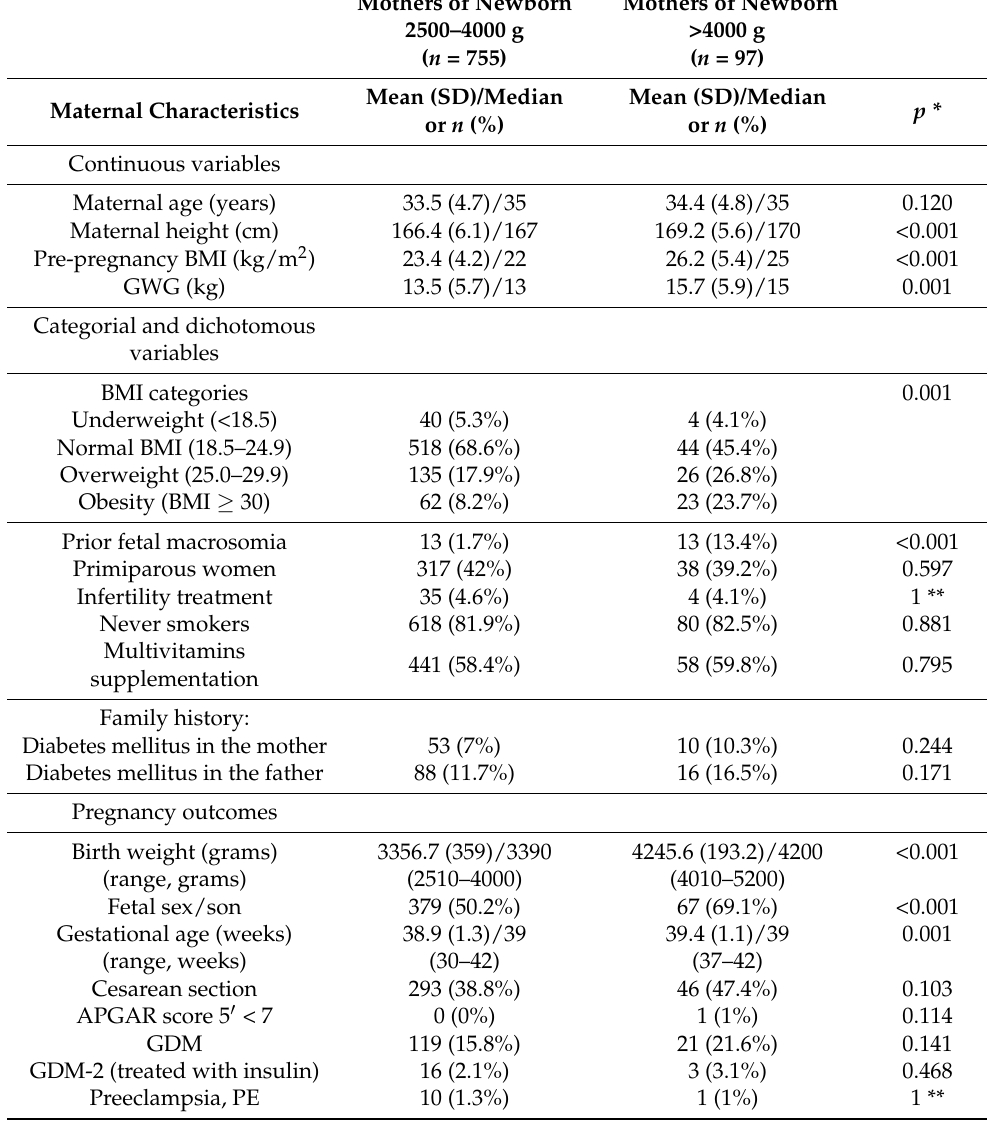
Table 2. Basic characteristics of women who gave birth to newborns with macrosomia > 4000